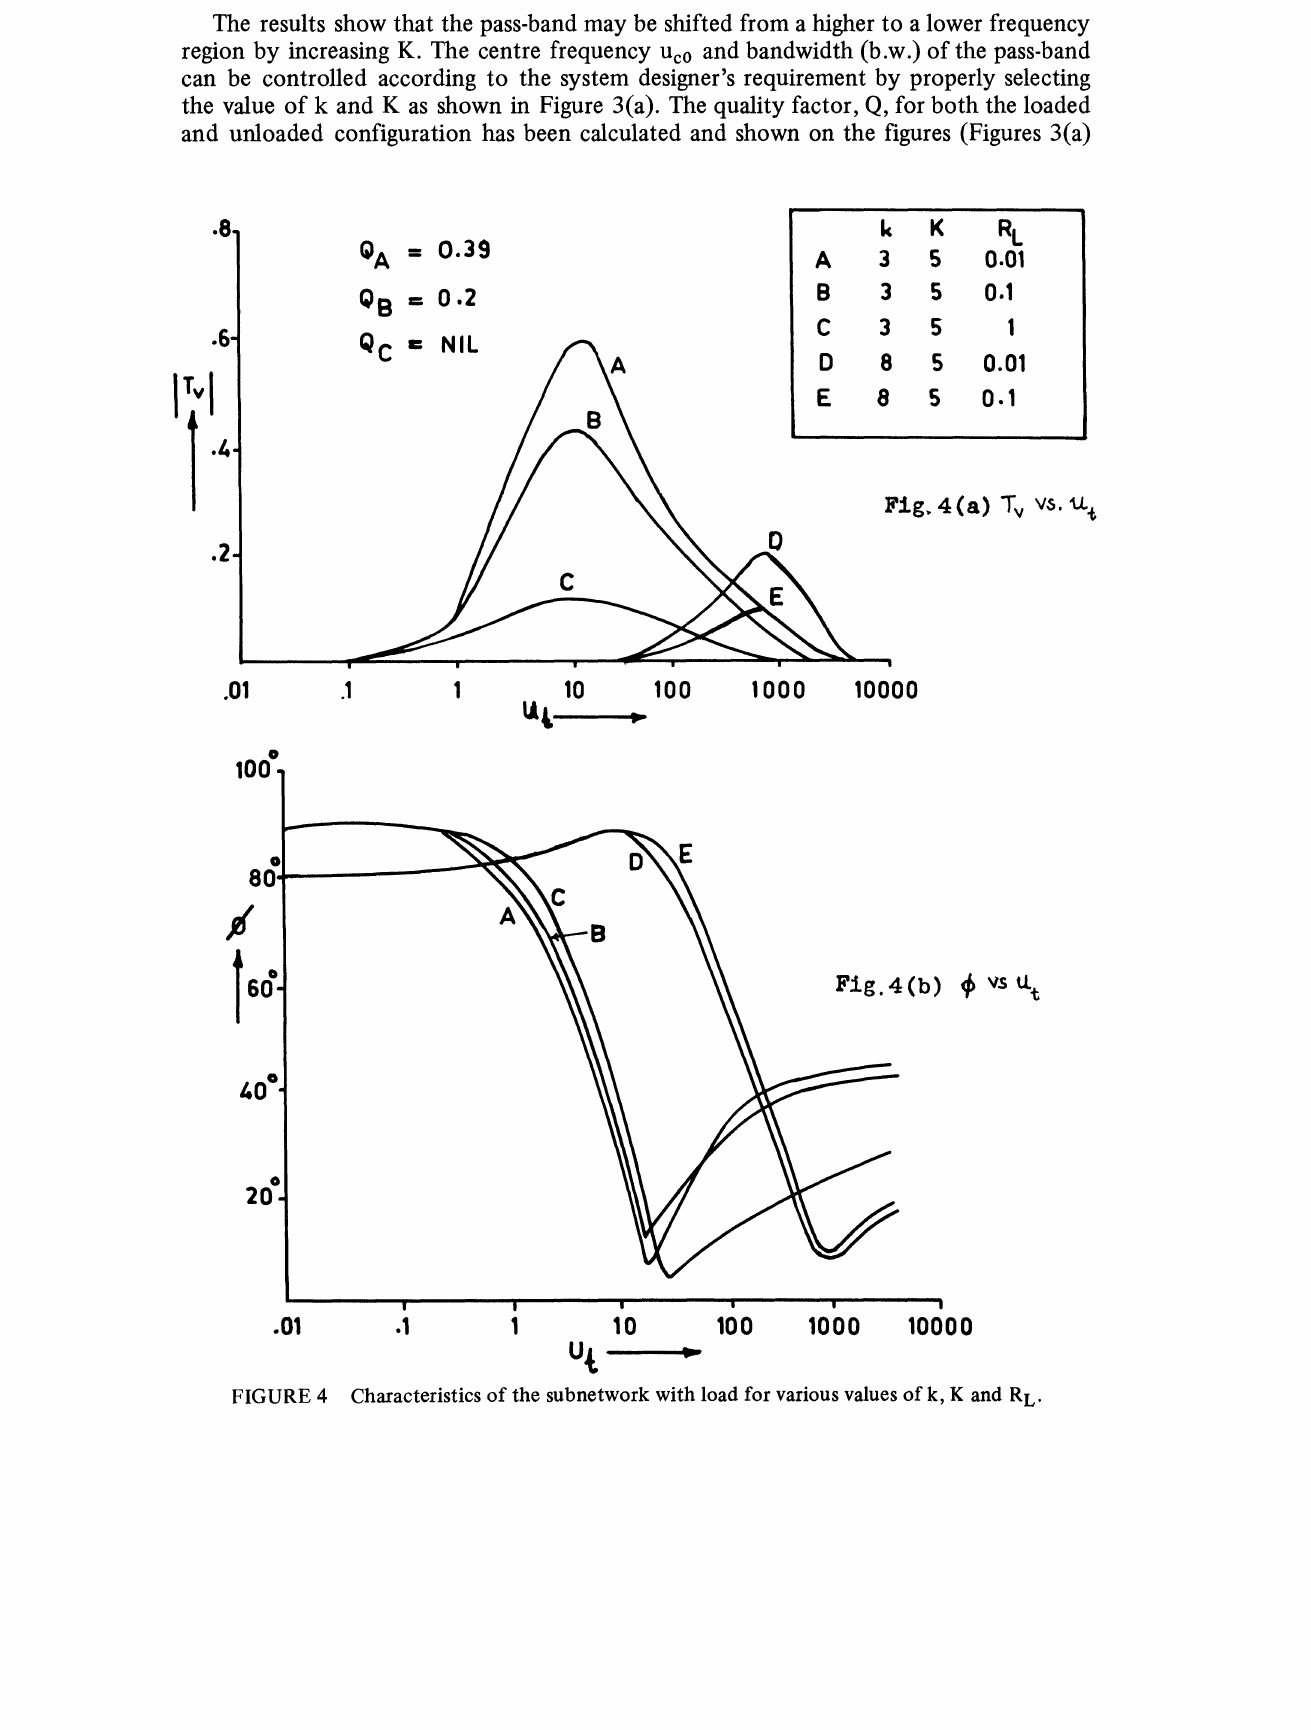
FIGURE 4 Characteristics of the subnetwork with load for various values of k, K and R